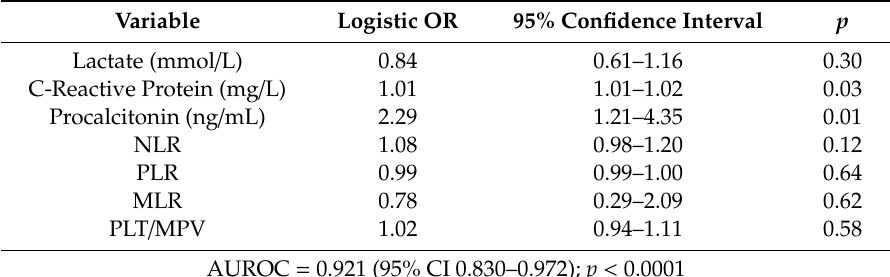
Table 5. Septic shock prediction in multivariate